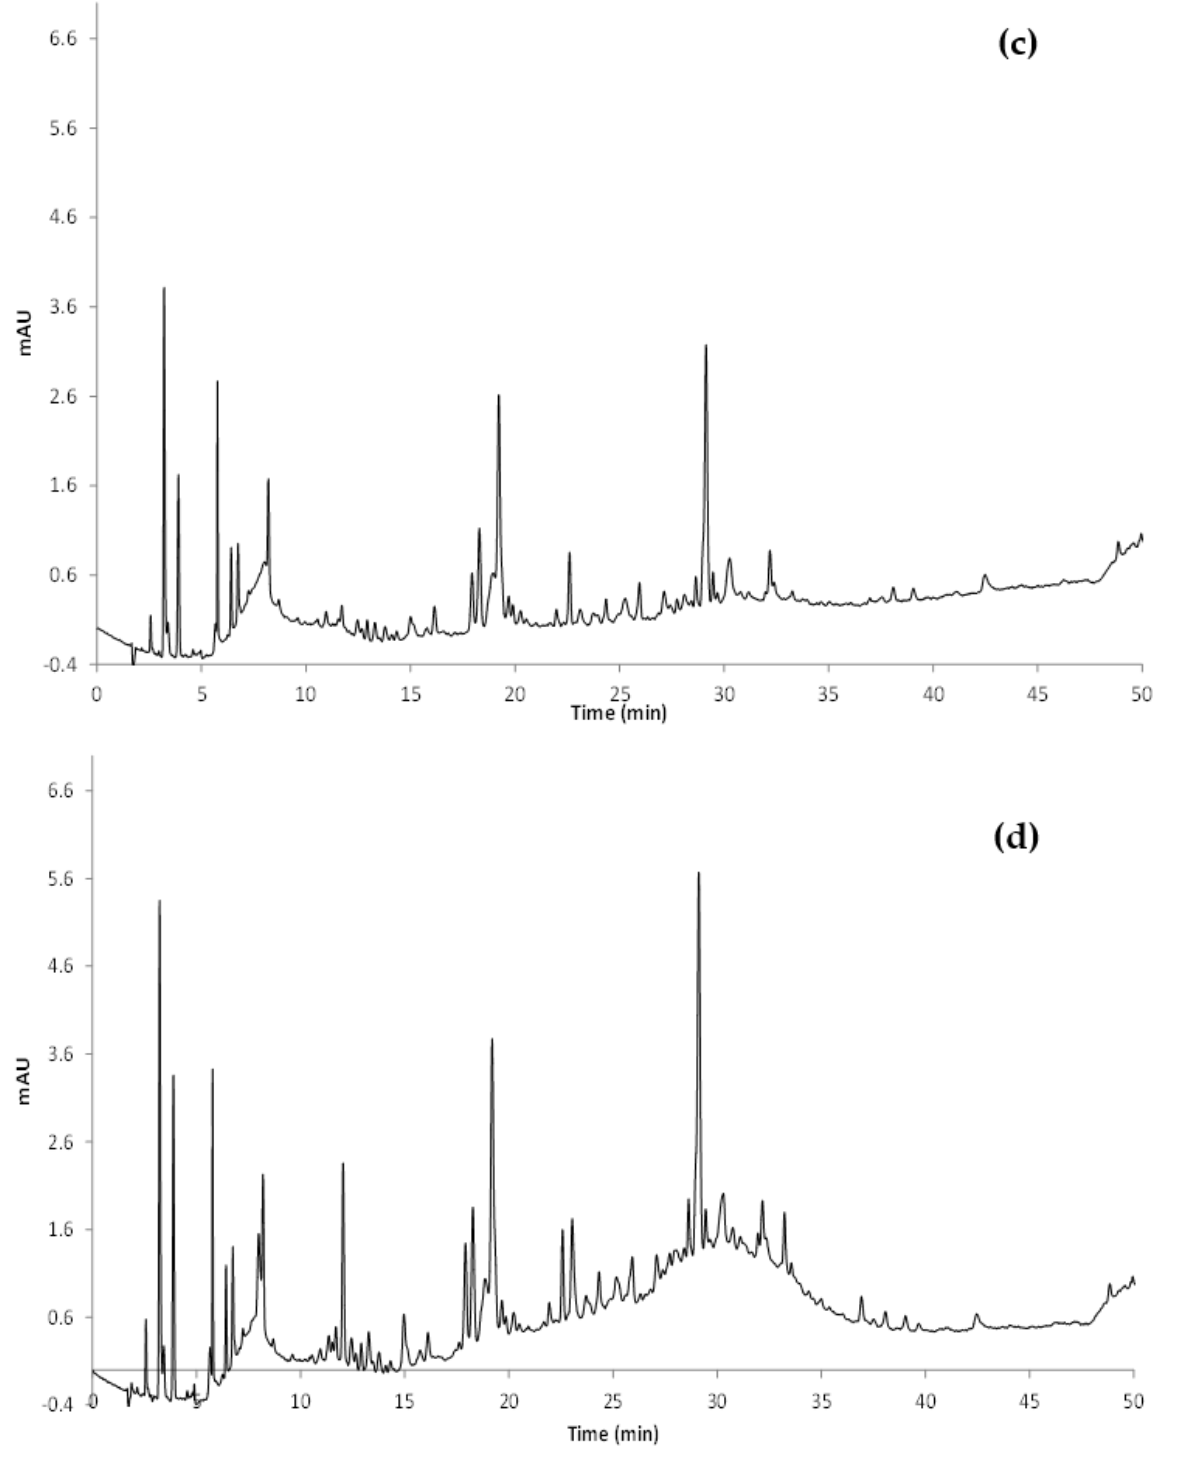
Figure 3. RP-HPLC chromatogram (at 280 nm). ( a ) First stage aqueous extract, water-acetic acid 5% (v/v); ( b ) Second stage methanolic extract, methanol ₋ acetic acid 5% (v/v) ; CONT. RP-HPLC chromatogram (at 280 nm). ( c ) Cake methanolic extracts, methanol-acetic acid 5% (v/v); ( d ) cake acetone extracts, 80% acetone-20% acidified water (v/v).